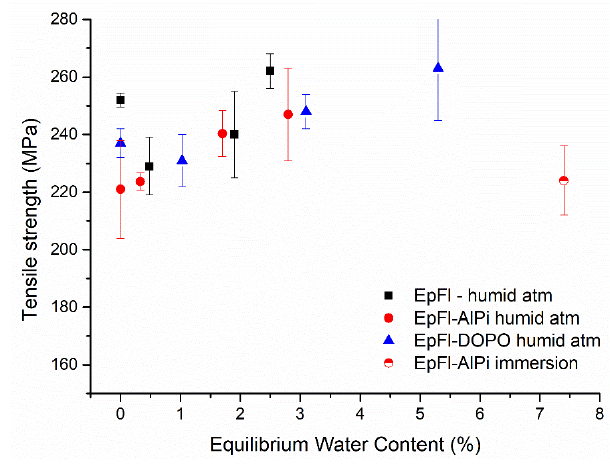
Figure 9. Tensile strength versus EWC for series aged at 70 ◦ C.